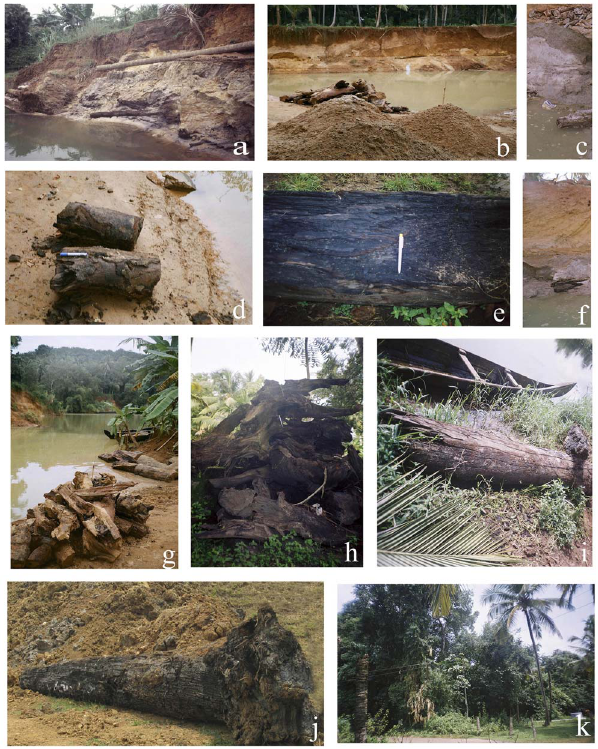
Figure 3. Field view of subfossil logs from wetlands of Kerala. (a) Vamanapuram River Bank, Thiruvananthapuram, , 3 km west of Parippally. (b), (d) and (g) Karamana River bank, Thiruvananthapuram. (c) and (f) Ayiroor. (e) Partially carbonized wood from Karippuzha, Alappuzha. (h) Heap of carbonized logs in the backyard of a coastal village, Pathiyoor. (i) Vettiyar, Alappuzha. (j) Coastal lowlands of Periyar River. (k) Sacred grove of Keerikkad village, Alappuzha.